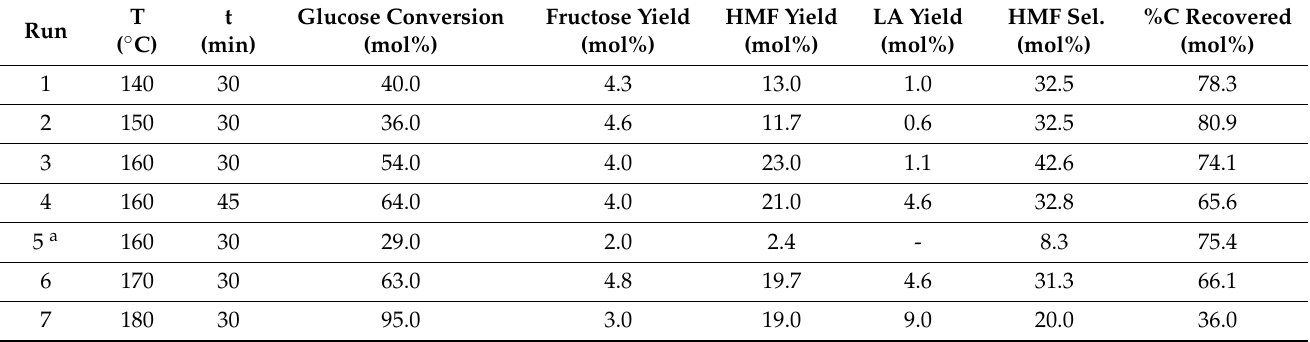
Table 3. MW-assisted conversion of glucose carried out in the presence of NbPO catalyst.